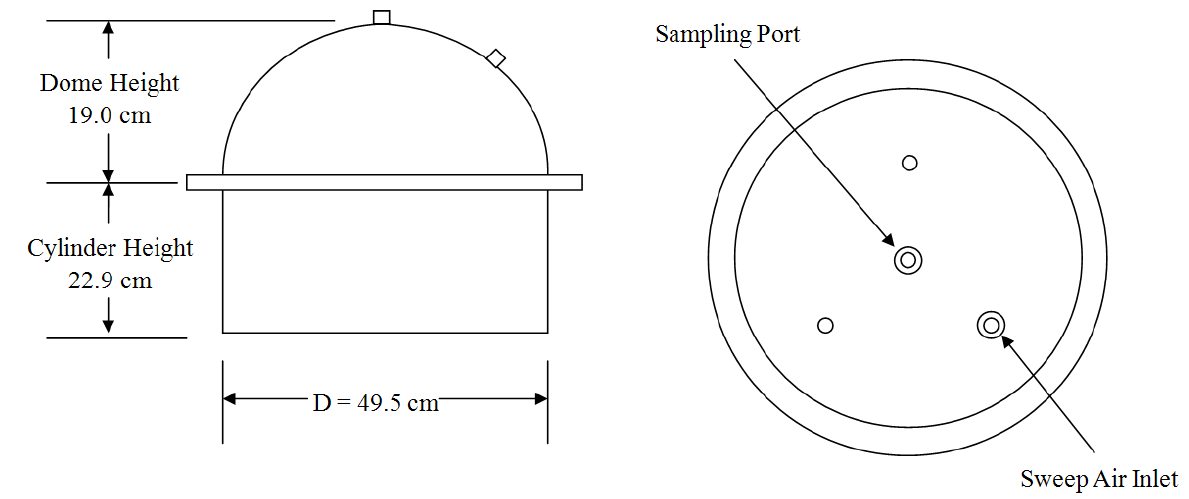
Figure 4. Diagram and dimension of the Flux Chamber used for air